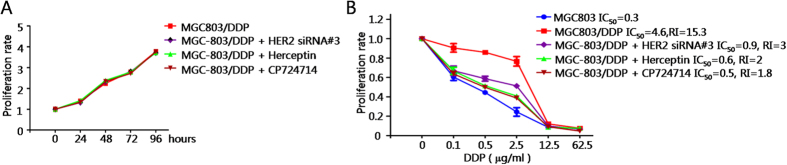
HER2 inhibition significantly reverses cisplatin resistance in MGC803/DDP cells.(A) Cell growth curve of cisplatin-resistant MGC803 cells with different treatments. Values represented the mean ± SD from two independent experiments with triplicate samples. (B) Effects of different treatments on IC50 and RI. Values represented the mean ± SD from three independent experiments with triplicate samples.